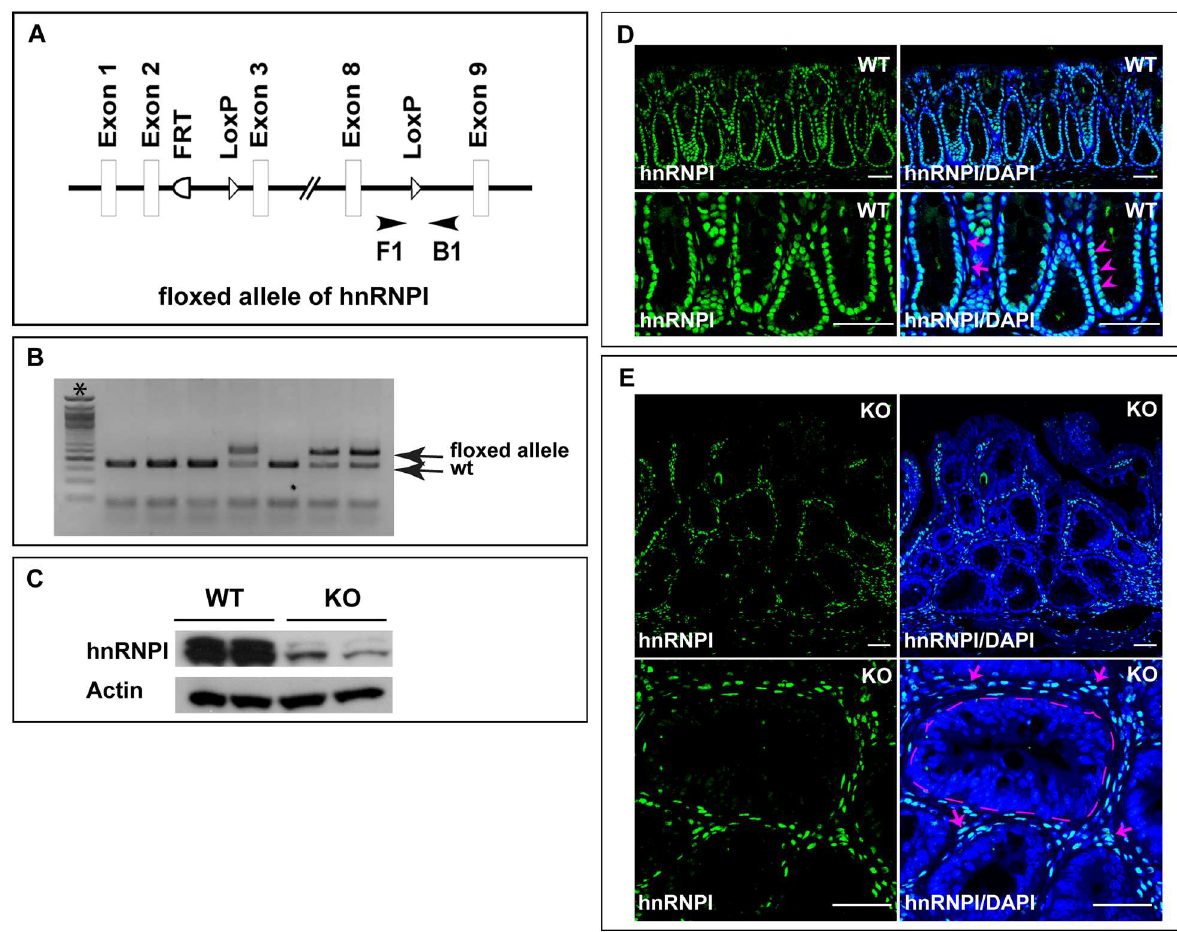
Fig 1. Generation of the IEC-specific hnRNPI knockout mice. (A) A schematic representation shows the knockout strategy. A primer pair (F1 and B1) flankingone loxP site (arrowheads) was used for genotyping the IEC-specific hnRNPI knockoutmice. (B) An exampleof genotyping PCR result shows the sizes of PCR products amplifiedfrom the hnRNPI floxed allele(236 bp) and wild-typeallele(166 bp). * , 50bp DNA ladder. (C) Western blotting result shows efficient ablation of hnRNPI in the colonicepithelialcells of the knockout mice. hnRNPI protein levels from two knockout mice and two control siblinglittermates are shown. (D) and (E) Immunofluorescence staining using an anti-hnRNPI antibodyshows hnRNPI protein localization in the wild-typeand hnRNPI knockout colon. Magnifiedimages are shown in the lower panels.Nuclear accumulation of hnRNPI protein was detected in both colonicepithelialcells (arrowheads)and cells in the lamina propria(arrows) in wild-typemice (D). hnRNPI expressionis diminishedin the nuclei of colonicepithelialcells in the knockout mice, but remainsunaffectedin the laminapropria cells (E, arrows). Note the increasednumberof immune cells in the lamina propriaof the knockout mice. The dotted line indicates the border of a centrally locatedcrypt. Nuclei were counterstained with DAPI. WT, wild-type; KO, knockout. Scale bars, 50 μ